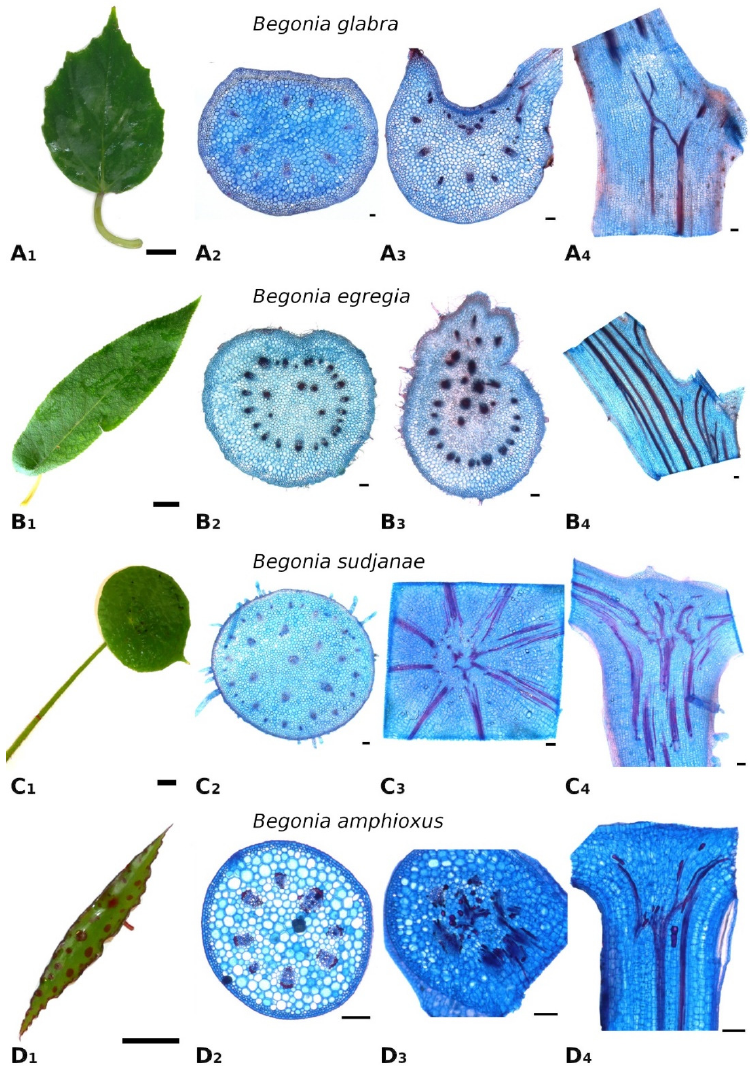
Figure 1. Leaf morphology and anatomy of Begonia glabra ( A ), B. egregia ( B ), B. sudjanae ( C ) and B. amphioxus ( D ). Leaf shape (A 1 ), cross-section of petiole (A 2 ), cross- (A 3 ) and longitudinal (A 4 ) section of petiole-lamina transition zone of B. glabra. Leaf shape (B 1 ), cross-section of petiole (B 2 ), cross- (B 3 ) and longitudinal (B 4 ) section of petiole-lamina transition zone of B. egregia. Leaf shape (C 1 ), cross-section of petiole (C 2 ), cross- (C 3 ) and longitudinal (C 4 ) section of petiole-lamina transition zone of B. sudjanae. Leaf shape (D 1 ), cross-section of petiole (D 2 ), cross- (D 3 ) and longitudinal (D 4 ) section of petiole-lamina transition zone of B. amphixous. Staining: astrablue/safranin. Scale: (1)—2 cm, (2–4)—100 µ m. All samples were taken from one plant per species (two for B. sudjanae